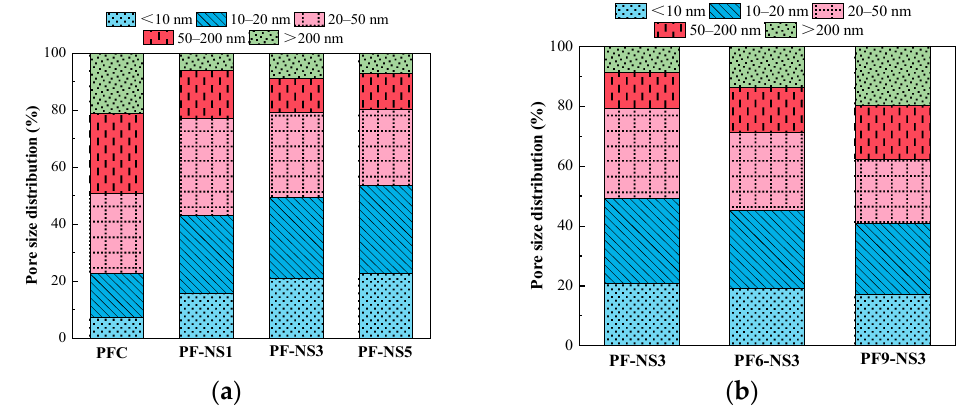
Figure 7. Pore-size distribution of selected sample with different dosages of ( a ) nano-SiO 2 and ( b ) polypropylene fiber.